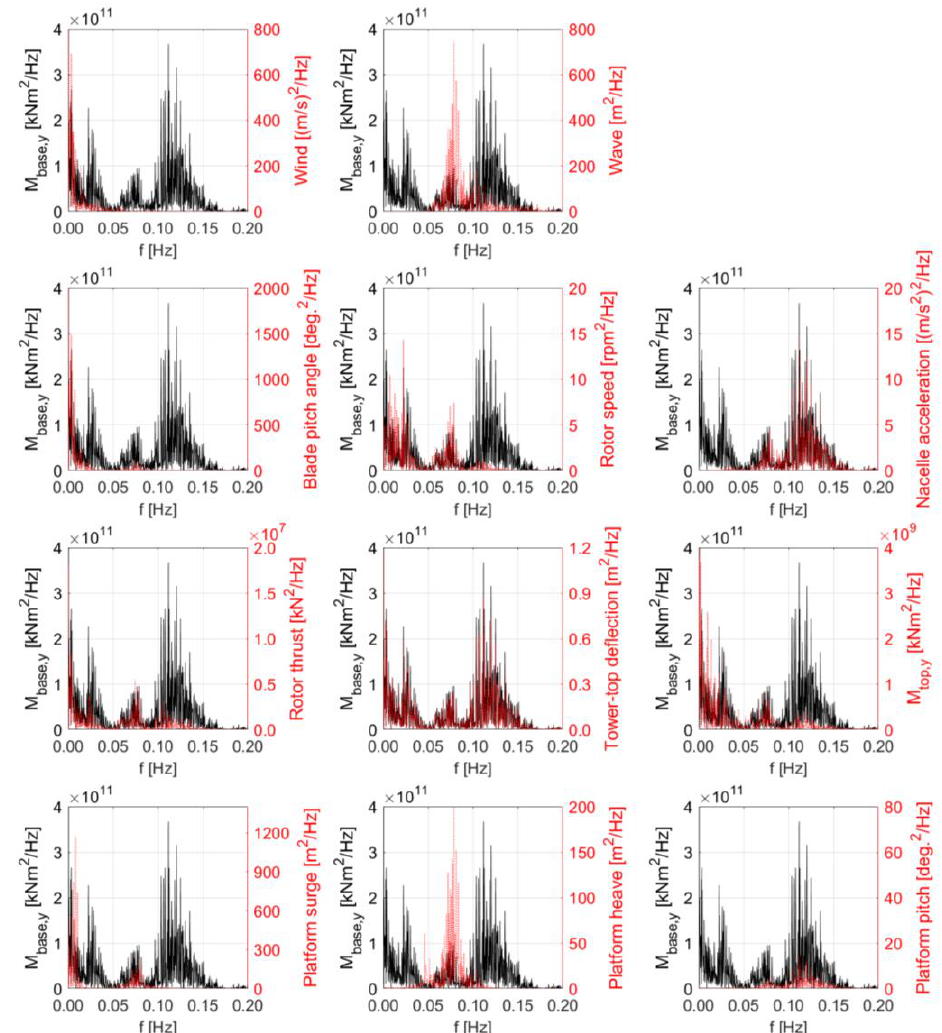
Figure 8. FFT results between tower-base pitch moment (black) and main output parameters